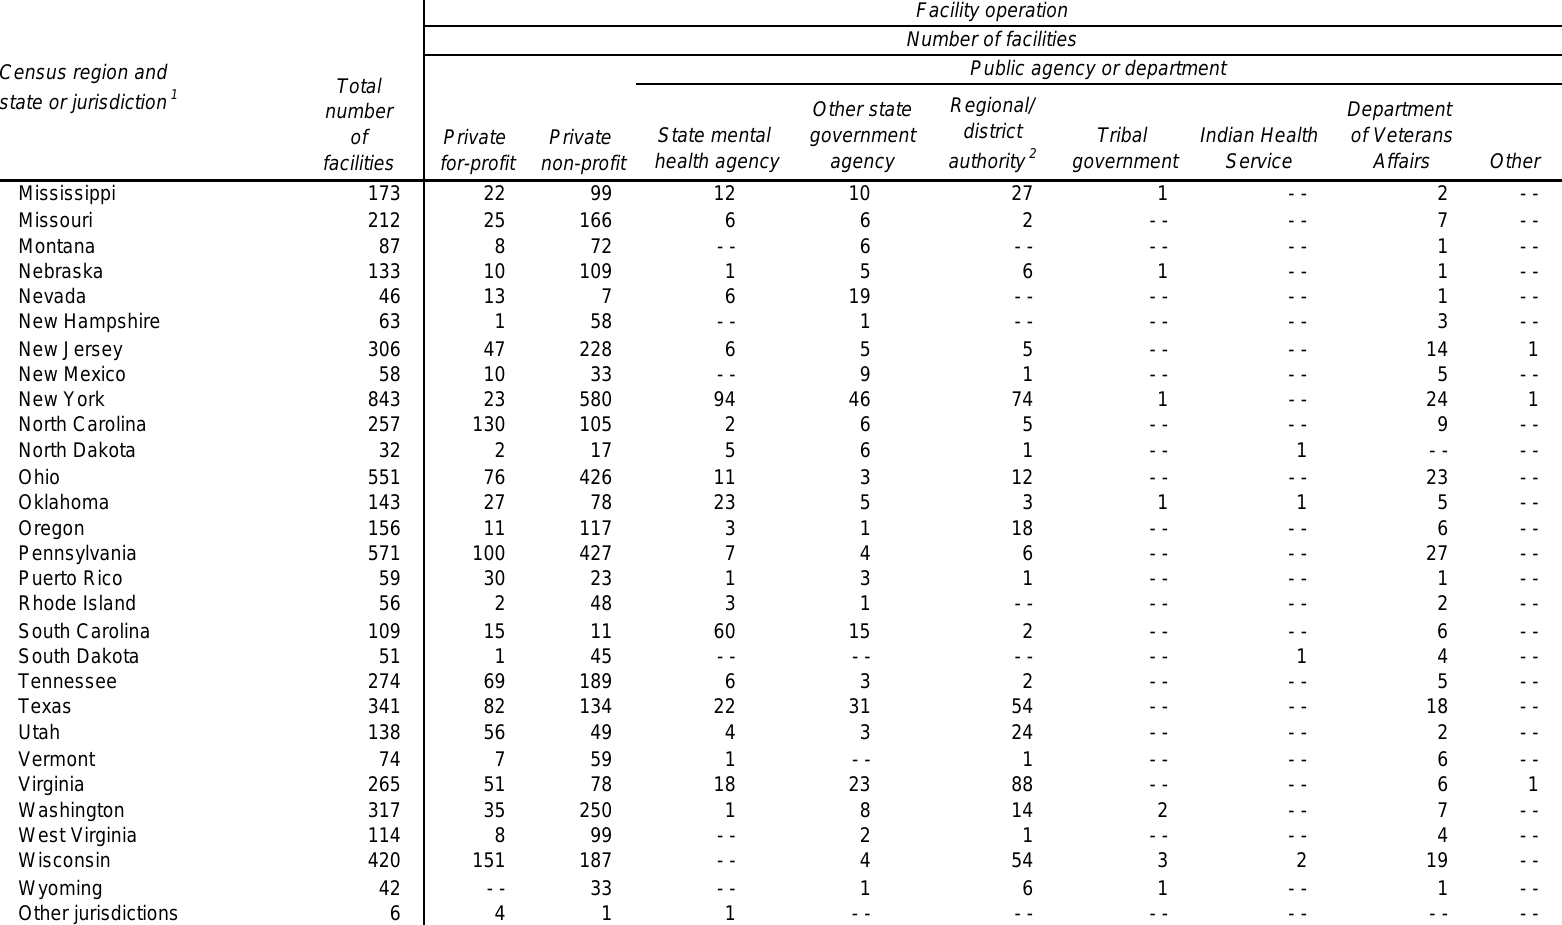
Table 3.2a. Mental health treatment facilities, by facility operation, Census region, and state or jurisdiction: Number, 2017 (continued)